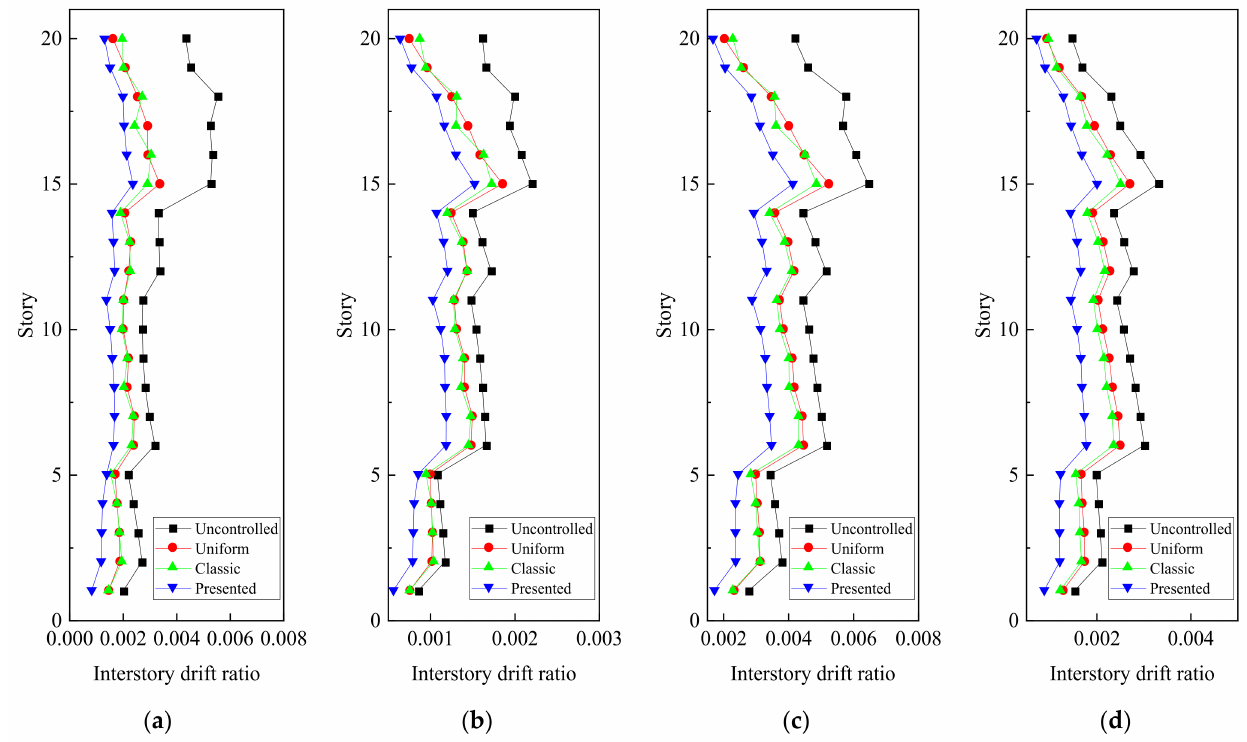
Figure 8. Normed inter-story drift ratio RMS of each story with different actuator placement: ( a ) Kobe; ( b ) El-Centro; ( c ) Tabas; ( d ) Artificial seismic